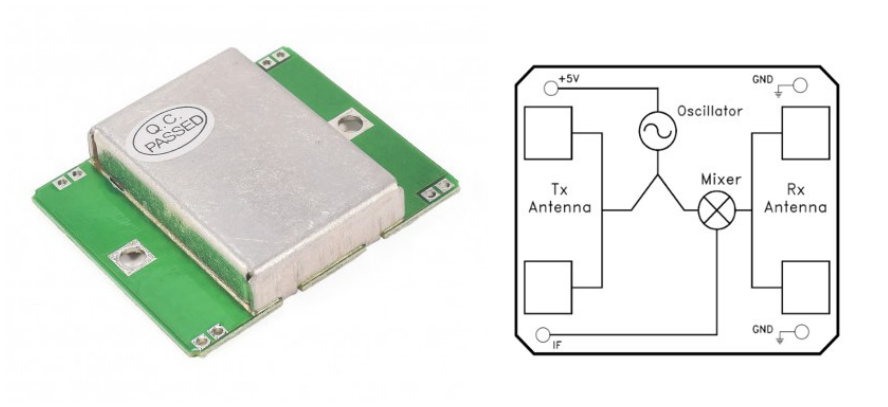
Figure 5. The low-cost RF Doppler sensor used as the odometry covariance sensor.